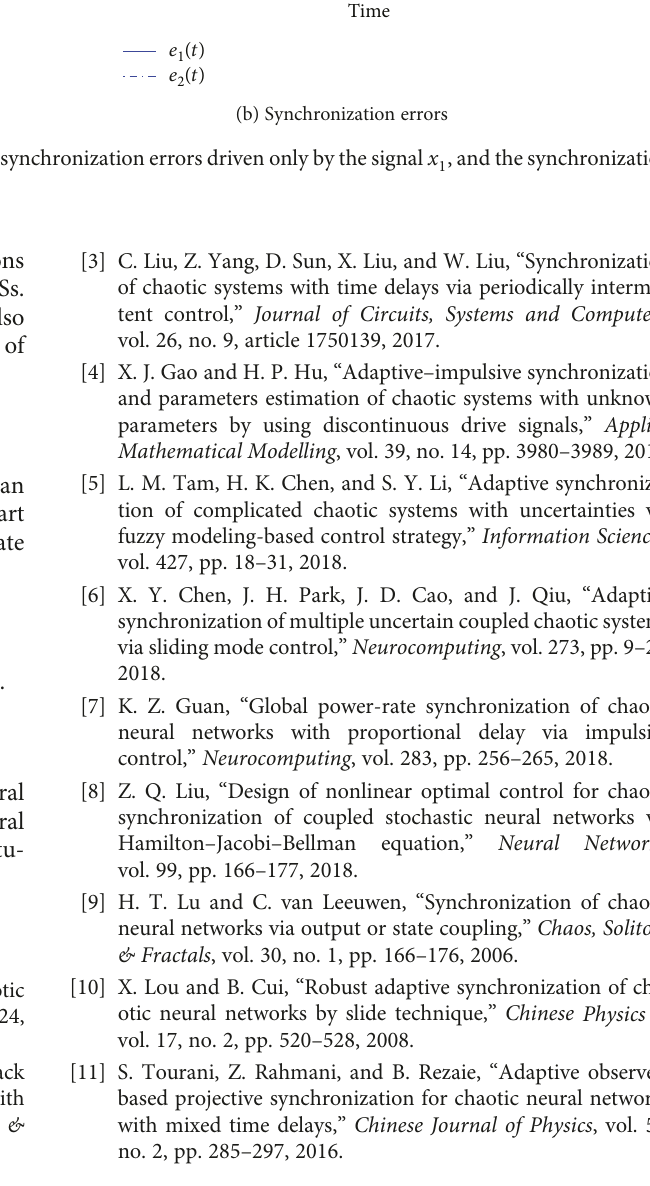
1 , and the synchronization